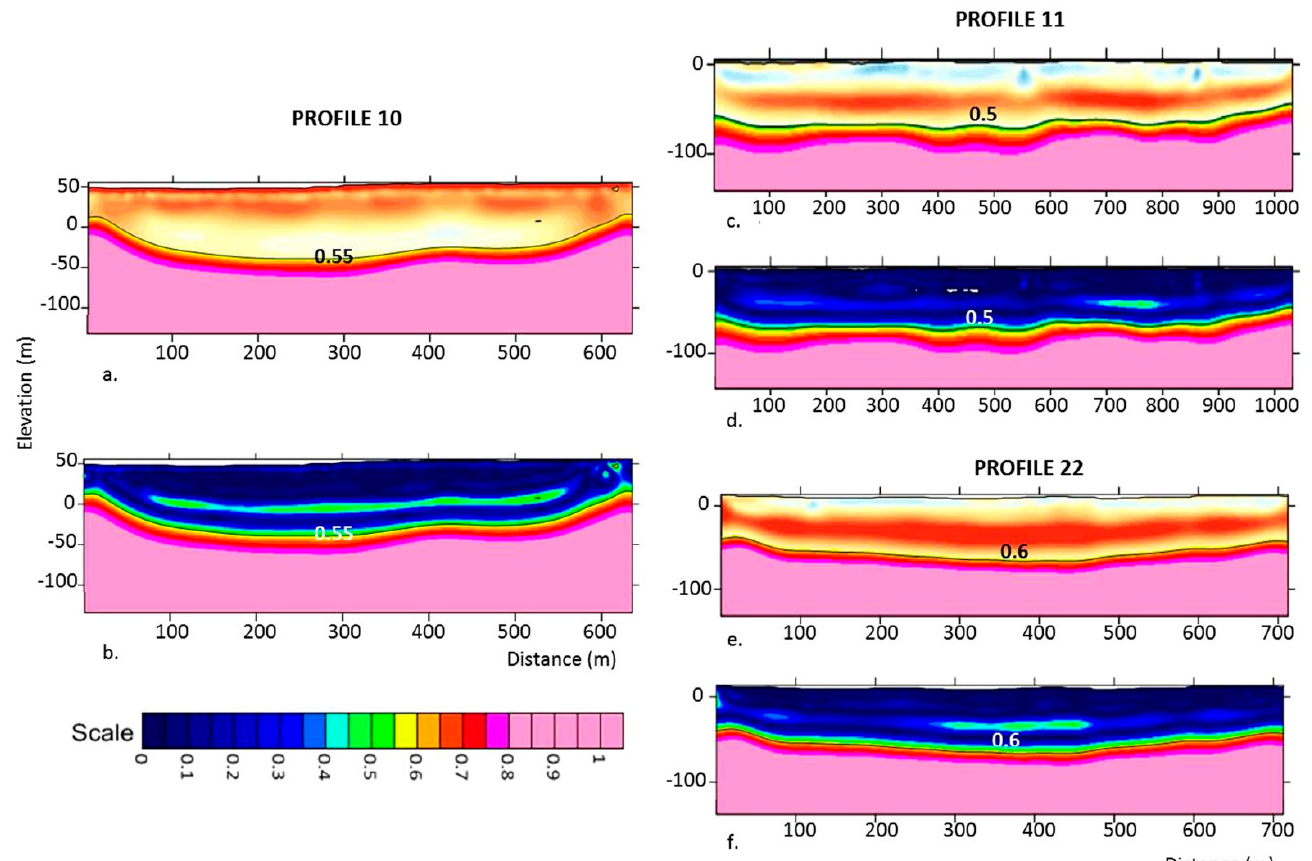
Figure 11. Three representative inverted images and corresponding DOI values. Threshold values to define the maximum penetration depth are chosen from 0.5 to 0.6. In each profile, the bottom image is a DOI map, while the top image is the ERT inversions filtered using the DOI. The well-resolved regions lie within low DOI index (dark blue); inversely, high DOI values indicate zone poorly constrained by the data (orange, red, and pink).